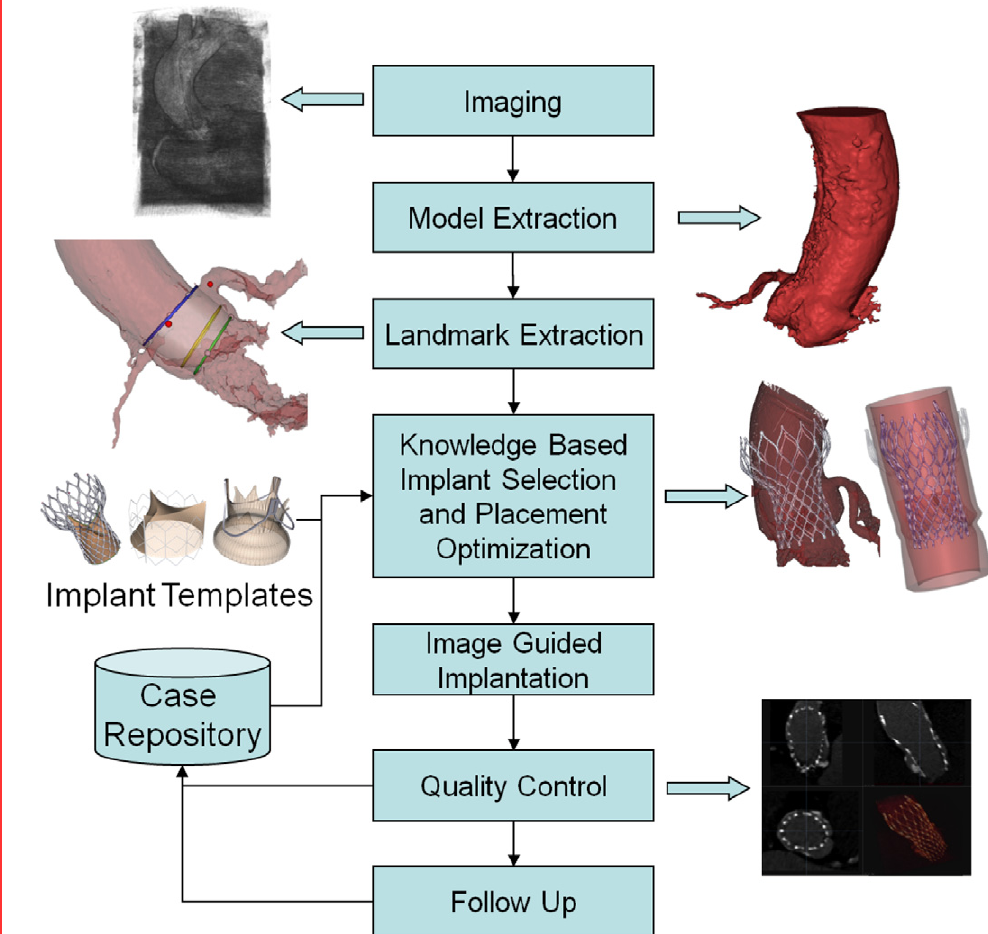
Figure. 8 Workflow and dataflow for knowledge-based implant selection and implantation